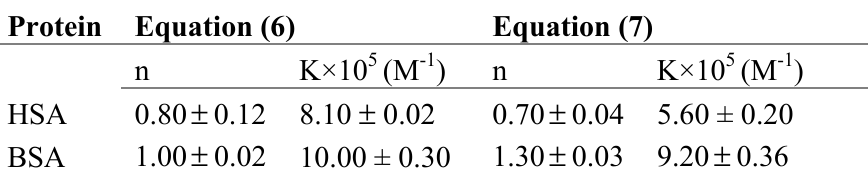
Table 2. Averaged binding parameters, n —the number of sites and K (M -1 )—the association constant, obtained by linear and non linear fittings of the fluorescence data for the albumin– I